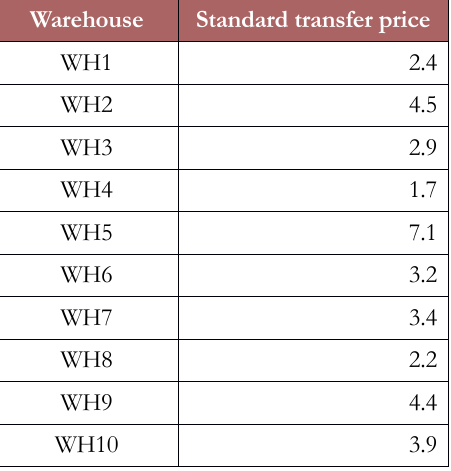
Table 7. Solution of a multiperiod